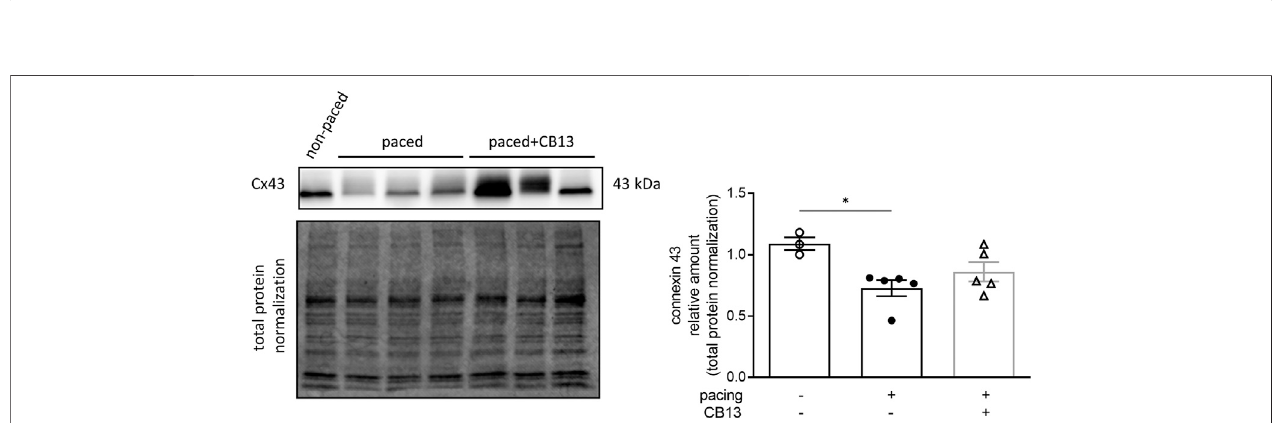
FIGURE 7 | Tachypacing-induced reduction of connexin 43 is diminished by CB13. (A) Cx43 is downregulated in tachypaced atrium compared to non-paced atrium. This effect of tachypacing demonstrated a lower tendency in the presence of CB13. * p ≤ 0.05. n (cid:1) 3 – 5. Data presented as mean ± SEM. Data was tested for normality using Shapiro-Wilk normality test. Accordingly, statistical analysis was performed by Kruskal-Wallis with Dunn ’ s post-hoc for multiple comparisons.